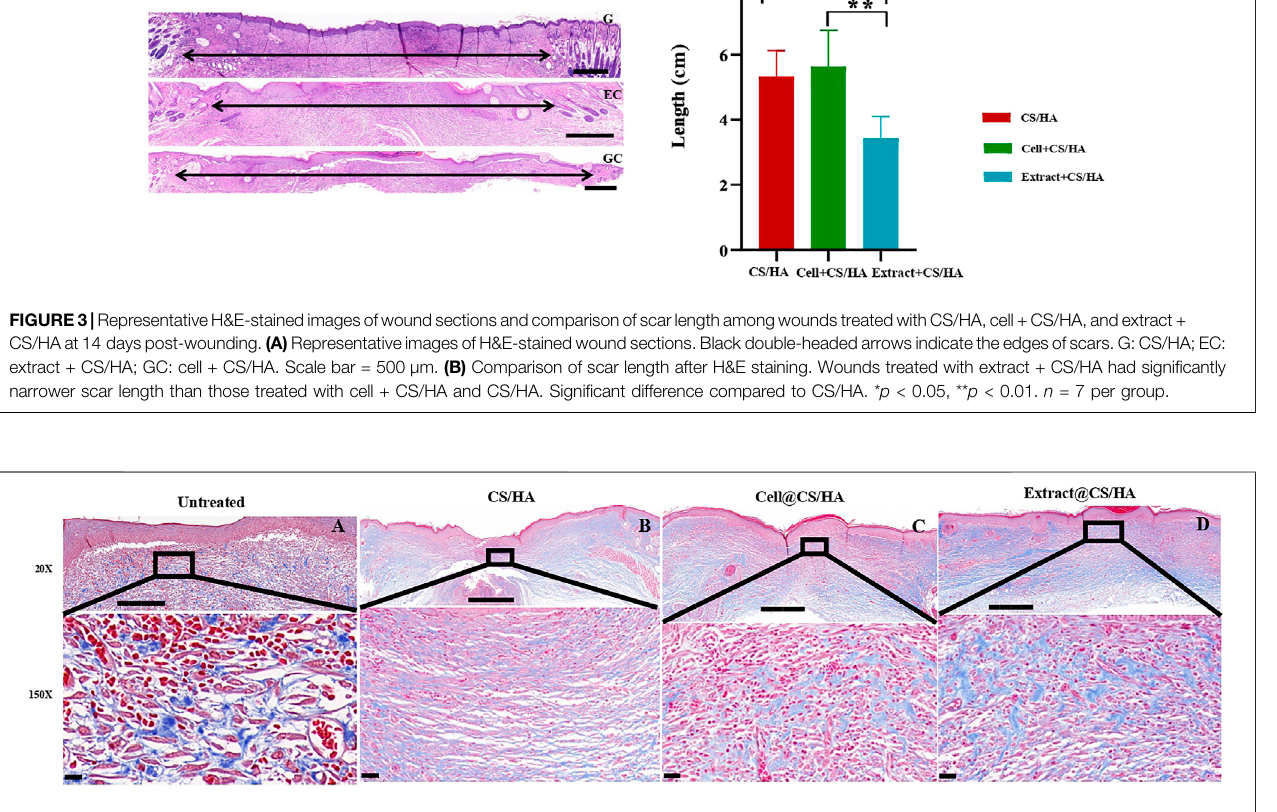
FIGURE 4 | The representative Masson ’ s trichrome images of untreated group ( n (cid:1) 1) (A) , CS/HA ( n (cid:1) 7) (B) , extract + CS/HA ( n (cid:1) 7) (C) , and cell + CS/HA ( n (cid:1) 7) (D) . Wound tissue was stained with Masson ’ s trichrome to access collagen content and organization at 14 days post-wounding. Scale bar: 200 μ m (top) or 10 μ m (bottom)